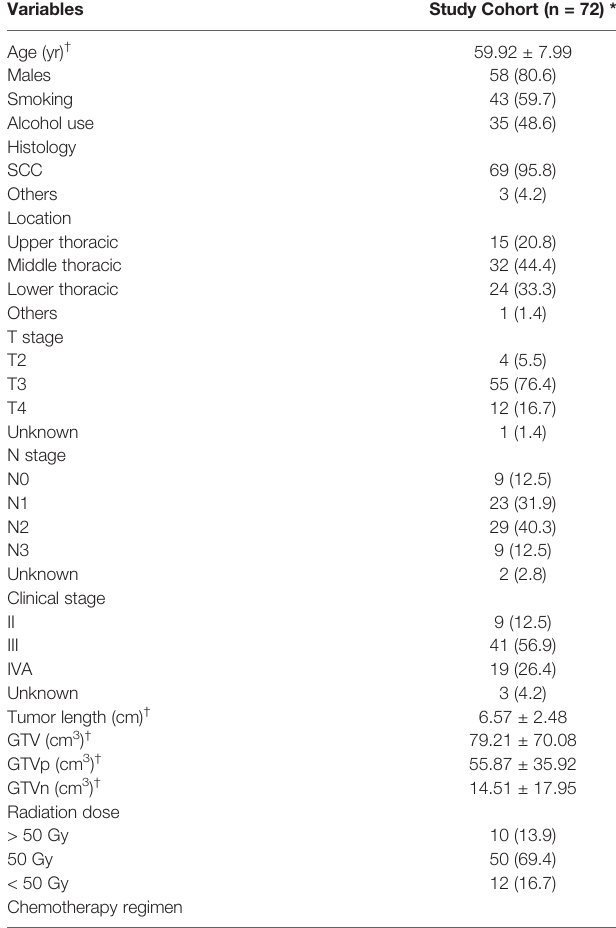
TABLE 1 | Patients and treatment